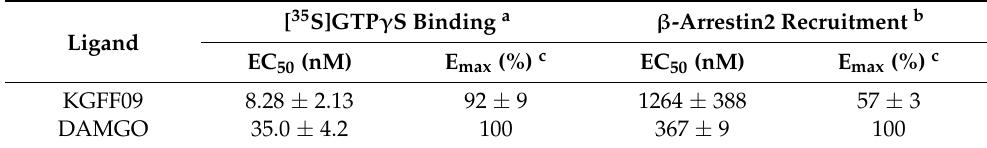
a Determined in the [ 35 S]GTP γ S binding assay with membranes from CHO cells that stably expressed the human MOR. b Determined in the PathHunter β -arrestin2 recruitment assay with U2OS cells that co-expressed the human MOR and the enzyme acceptor tagged β -arrestin2 fusion protein. c E max Table 1. Potencies and efficacies to the human MOR of KGFF09 in comparison to DAMGO in (%) values represent the percentage relative to the maximal effect of DAMGO (as 100%). Values functional in vitro assays for G protein activation and β -arrestin2 recruitment. represent the mean ± SEM ( n = 3). [ 35 S]GTP γ S Binding a Ligand DAMGO 35.0 ± 4.2 100